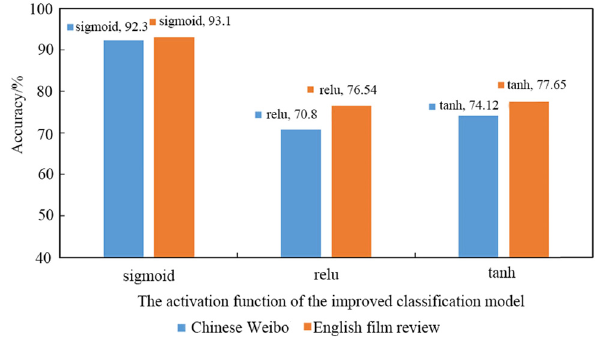
Figure 5: The in fl uence of di ff erent activation functions on the accuracy of the improved classi fi cation model.